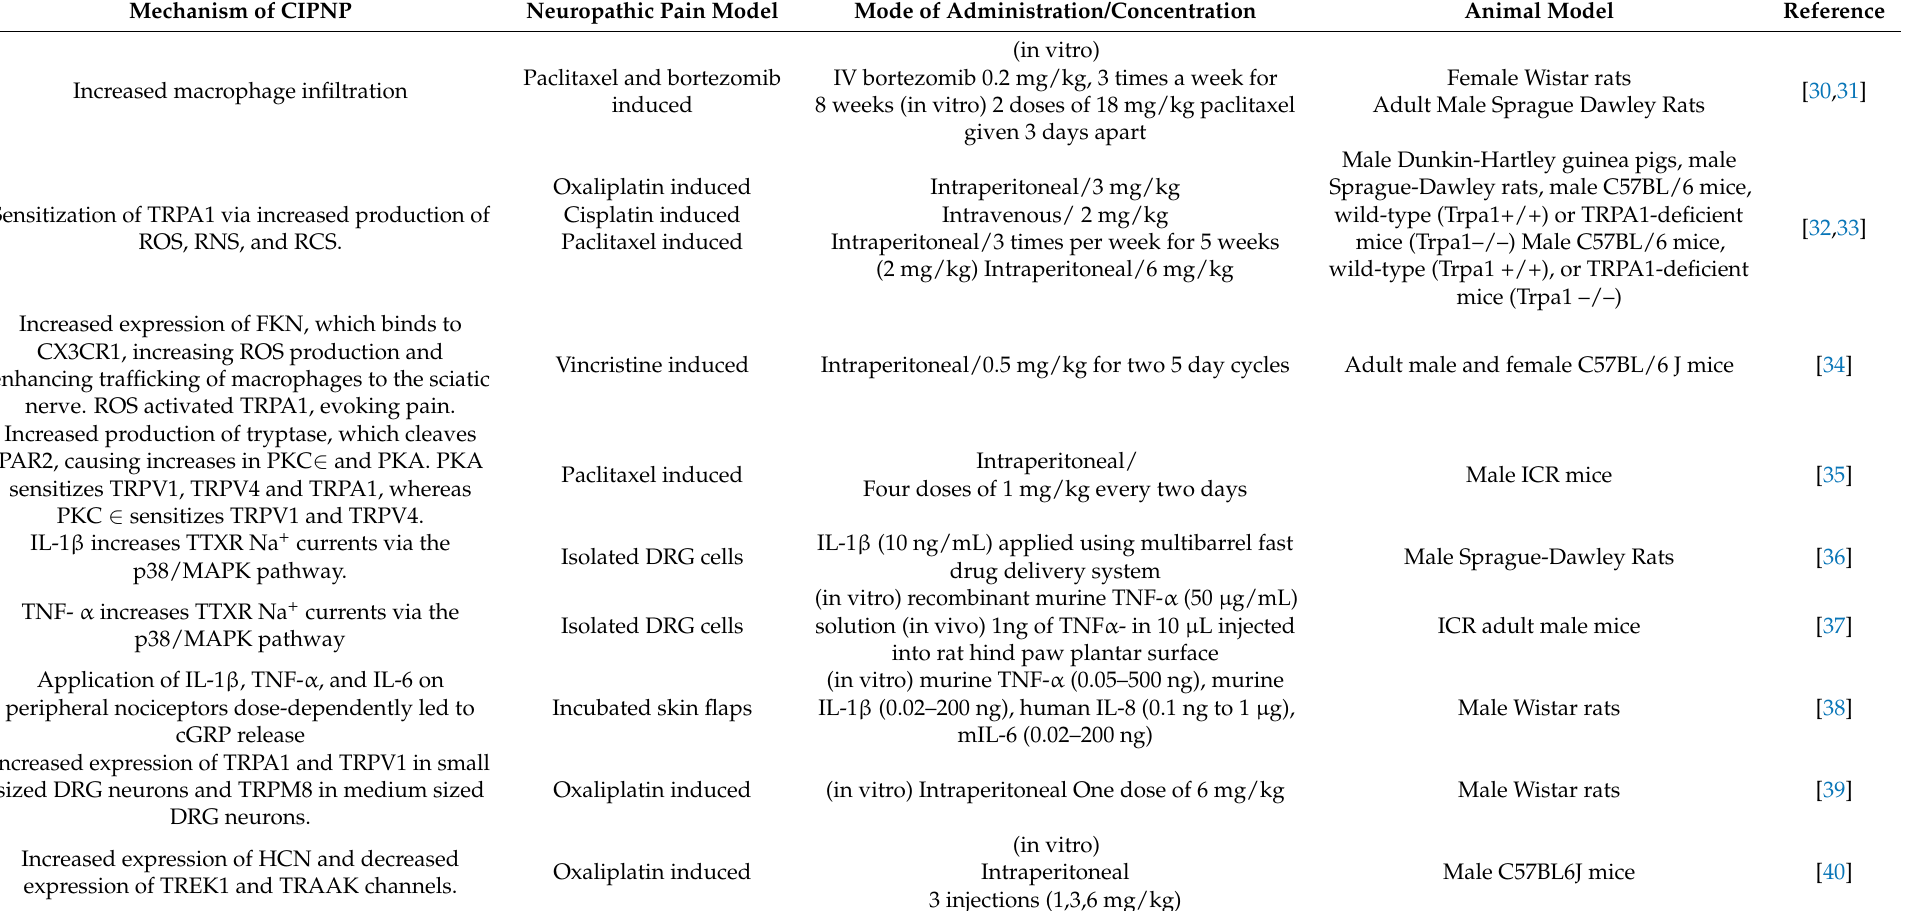
Table 1. Mechanisms of CIPN at the peripheral nociceptor induced by anticancer